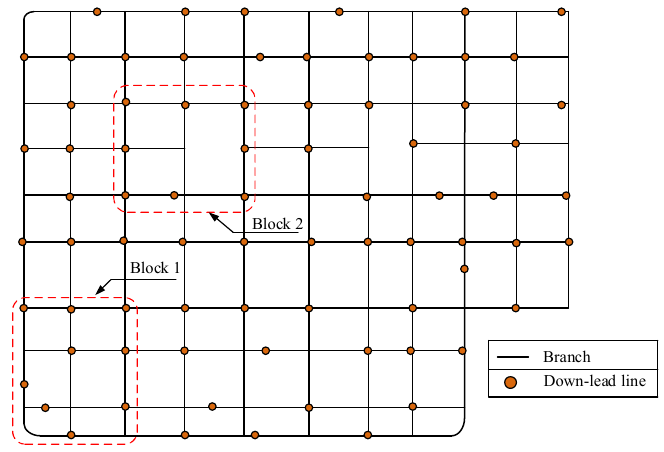
Figure 13. The structure of a 220 kV grounding grid.